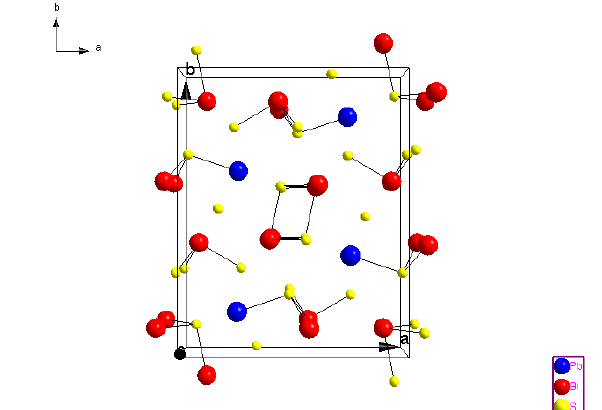
S )(PbS) thin films. 2 3